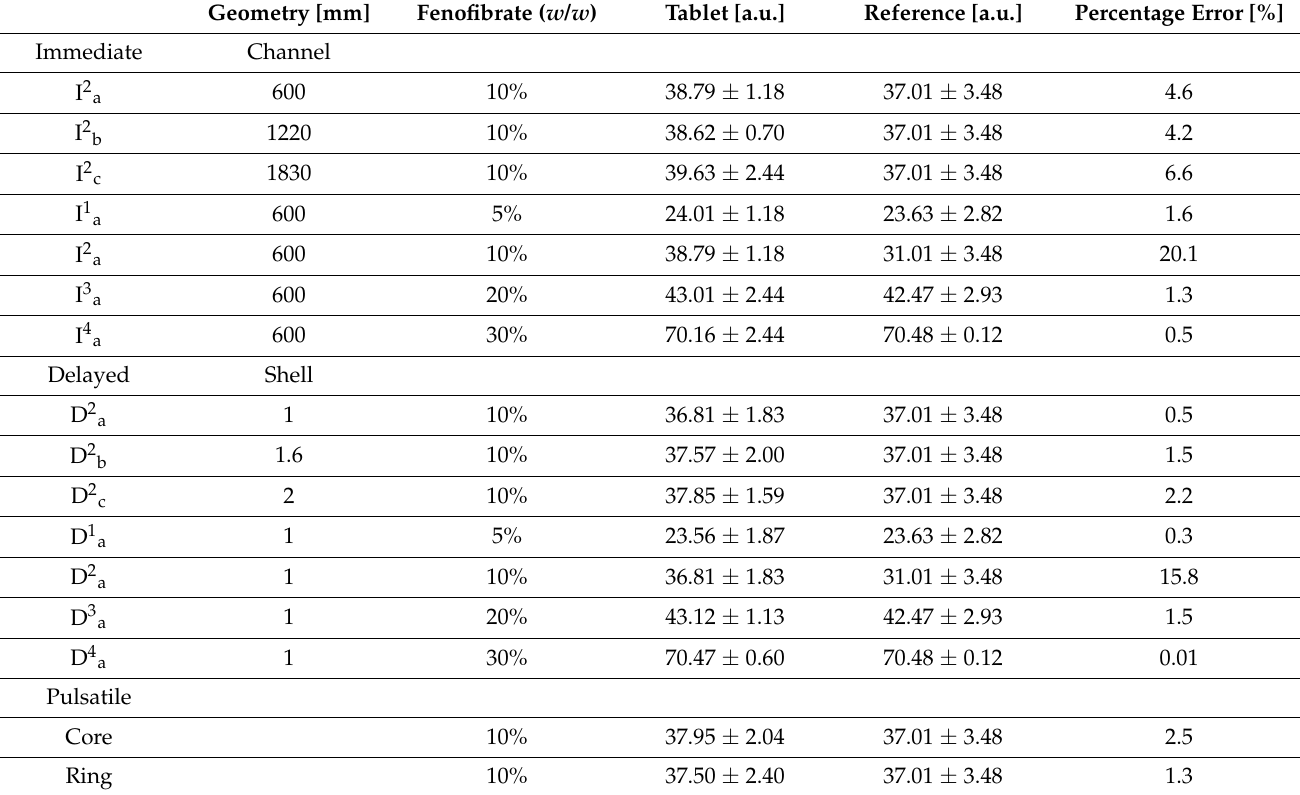
Table 1. FTIR characterisation of tailored release tablets via the intensity of the Fenofibrate characteristic 765 cm − 1 peak. Geometry [mm] Fenofibrate ( w / w ) Tablet [a.u.] Reference [a.u.] Percentage Error